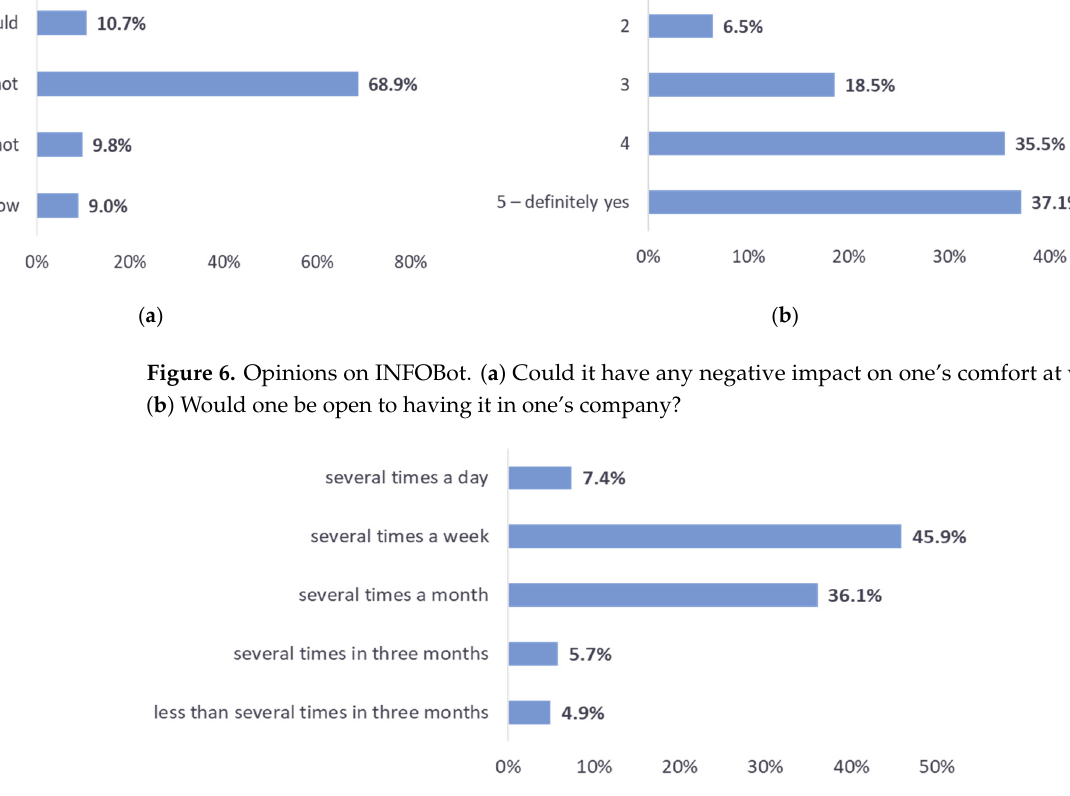
Figure 7. The willingness to receive several INFOBot questions in a given amount of time.